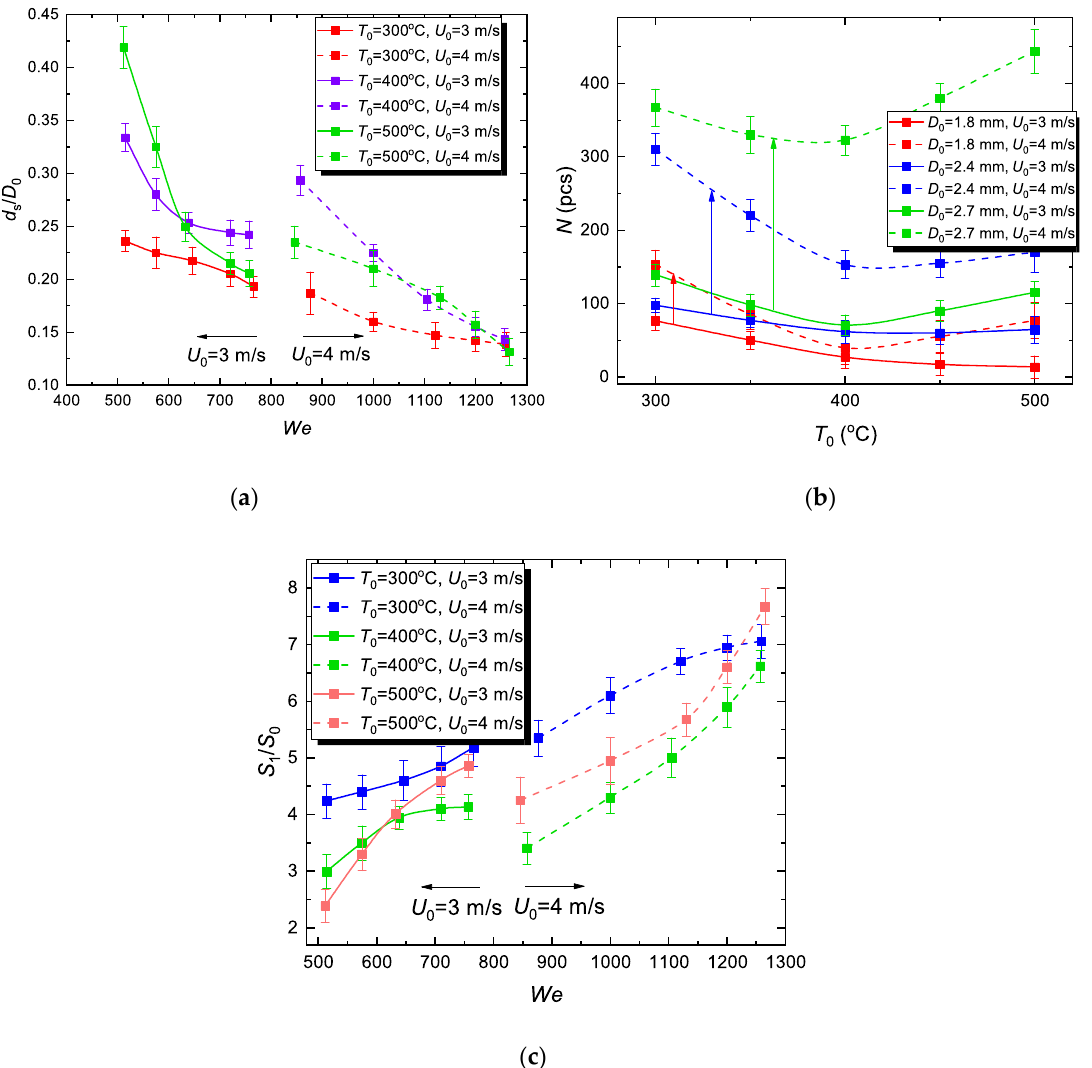
Figure 7. Effect of WiDME (C-6) drop interaction velocity on variation of the mean diameter of child droplets generated by hydrodynamic breakup ( a ), their number ( b ), and evaporation surface area ( c ) at various surface temperatures.